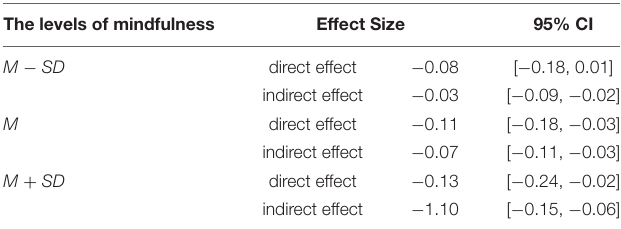
TABLE 3 | The direct effect of parental attachment and mediating effect of alexithymia at two levels of mindfulness. The levels of mindfulness